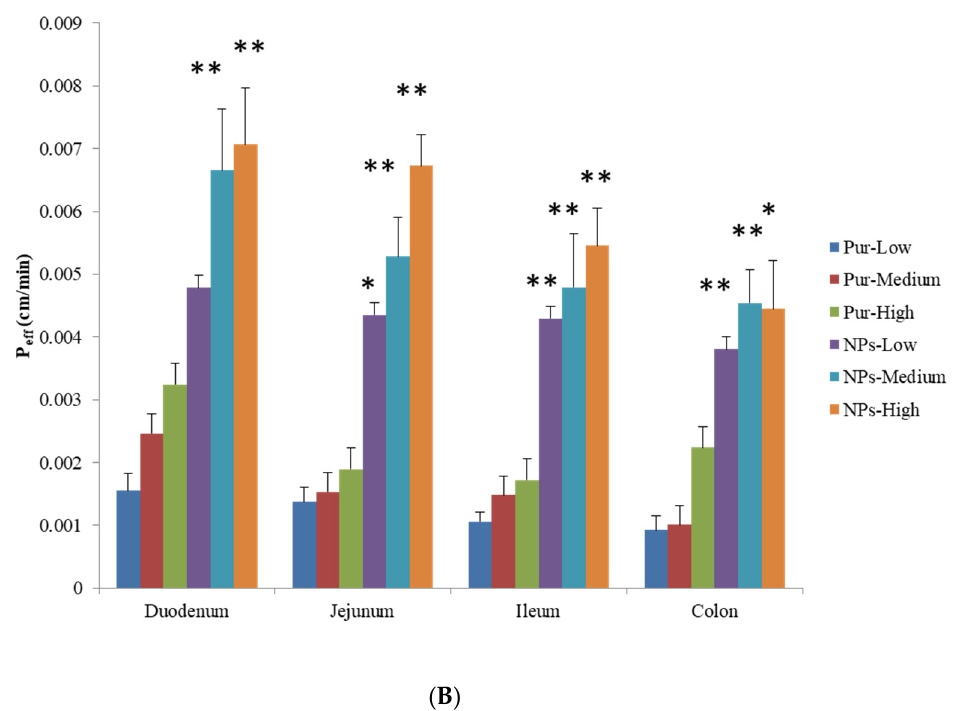
Figure 5. Comparison of K a (A) and P eff (B) of Pur and Pur-CS/TPP-NPs in low, medium, and high dose groups. ( n = 6 x ± s) (* p < 0.05, ** p < 0.0001 compared with Pur).